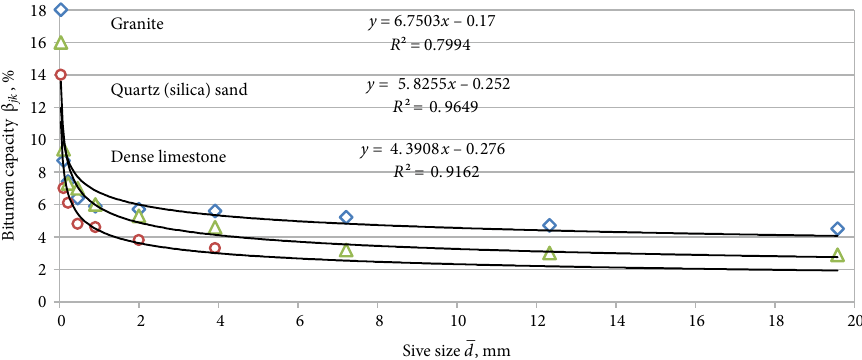
Fig. 2. The dependence of bitumen capacity β of the narrow fractions of mineral materials from jk different rocks on their average diameter d obtained using a set of old standard laboratory sieves